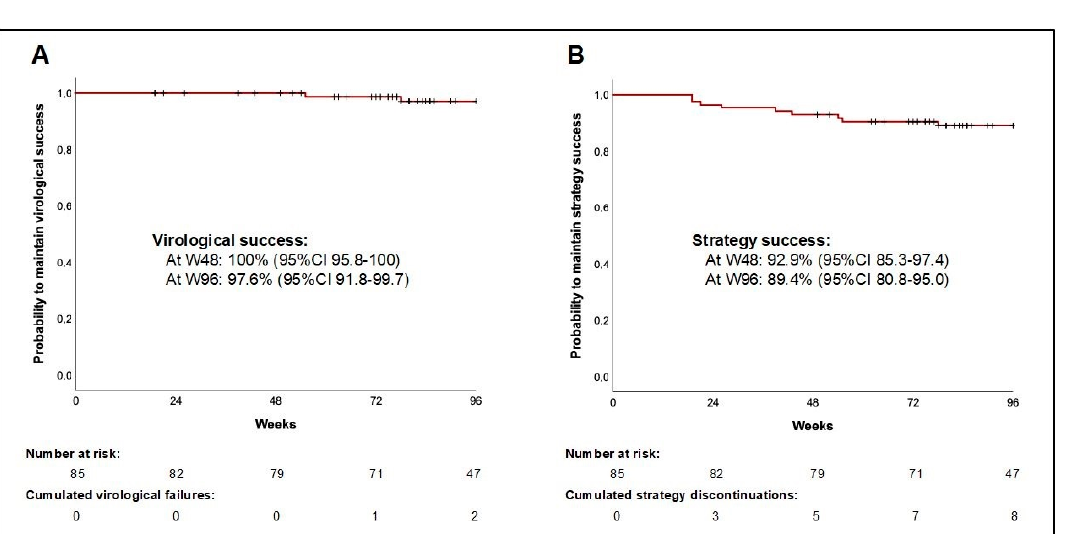
Figure 1. Virological success rate ( A ) and strategy success rate ( B ) under intermittent B/F/TAF over time.